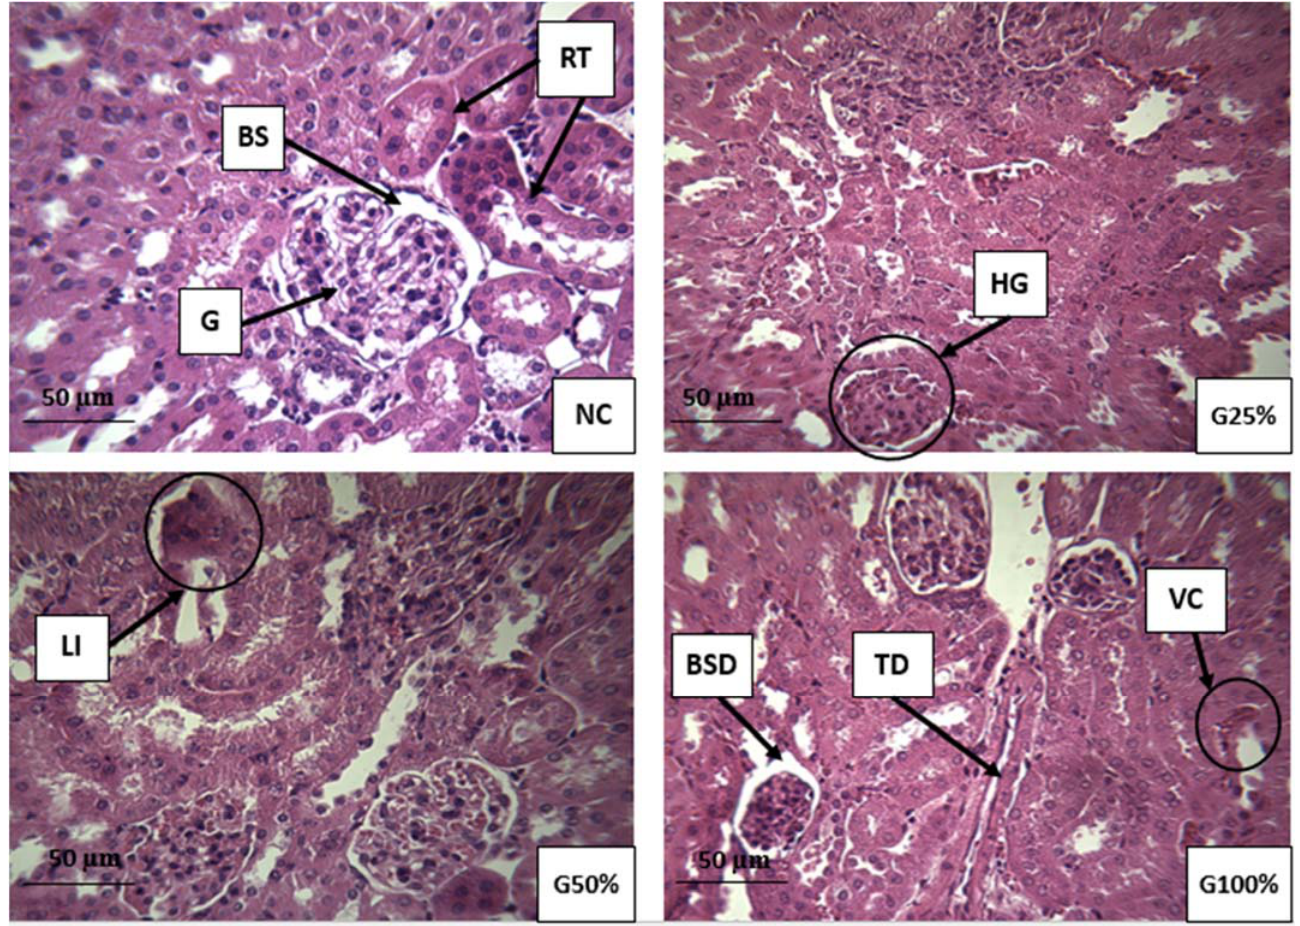
Figure 3. Histological sections of the kidney from mice exposed to various dilutions of TDE (H&E, ×400). NC: Kidney section from negative control mice group showing apparently normal structure of nephron’s the cortex and medulla. G25%: kidney section of mice receiving 25% diluted TDE. G50%: kidney section of mice receiving 50% diluted TDE. G100%: kidney section of mice receiving 100% TDE. G, glomerulus; BS, Bowman’s space; RT, renal tubules; VC, vascular congestion; LI, leucocyte infiltration; HG, hypertrophied glomerulus; BSD, Bowman’s space dilatation; TD, tubular dilatation.